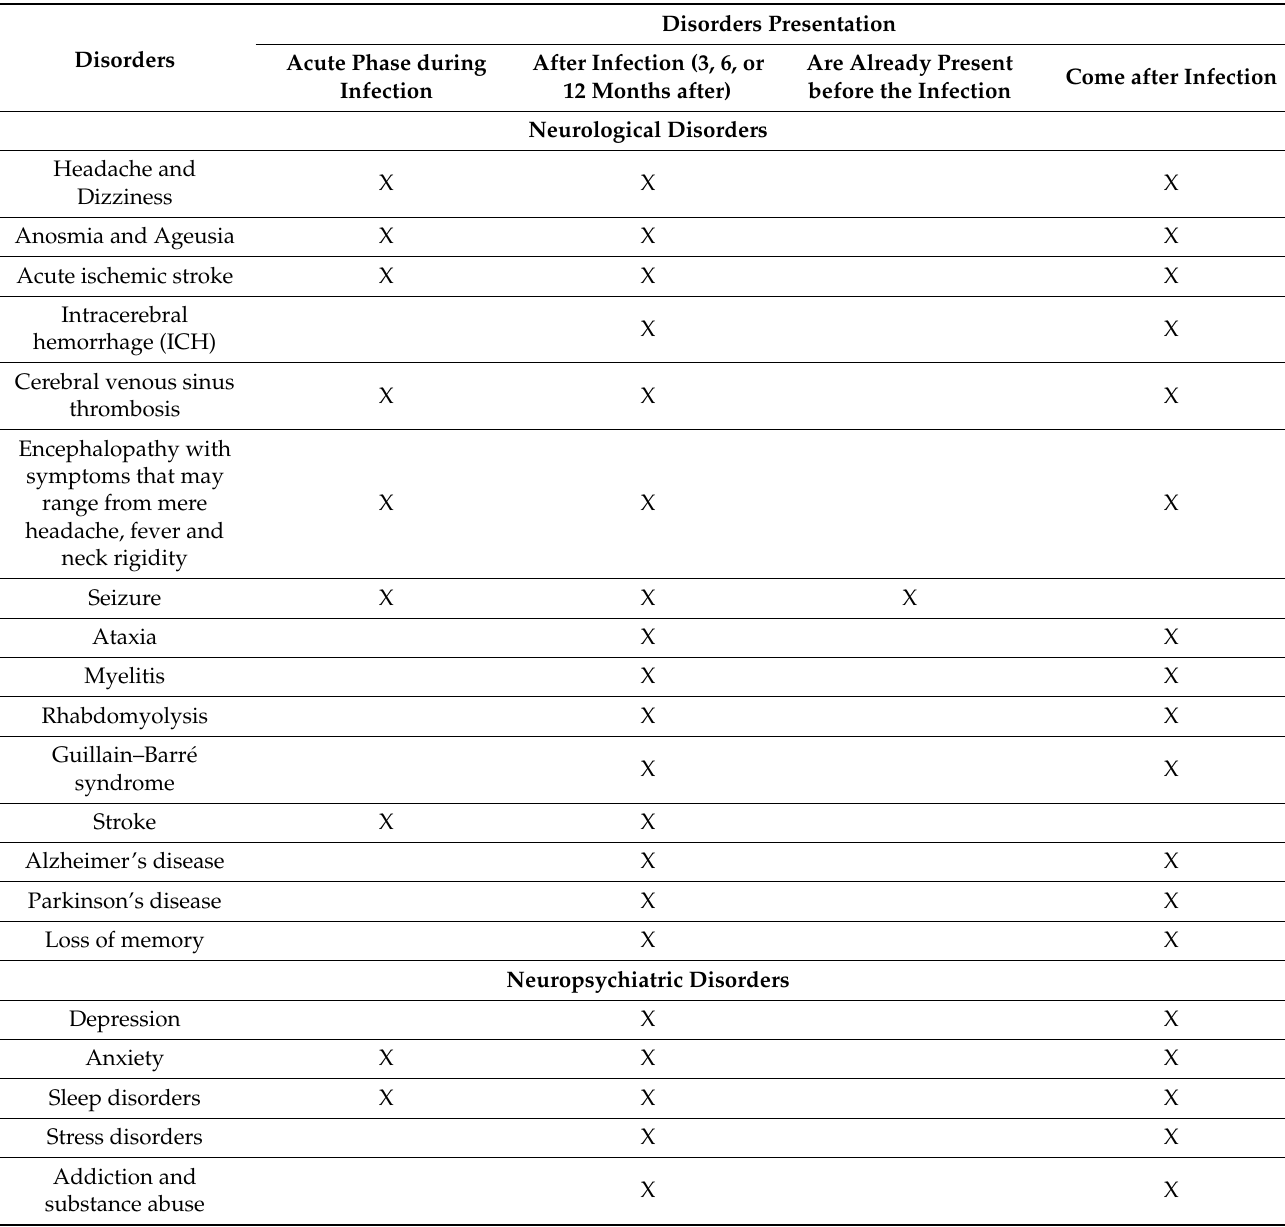
Table 1. Main neuropsychiatric disorders related to COVID-19, with its most common phase of presentation (during or after the infection and already before the infection or